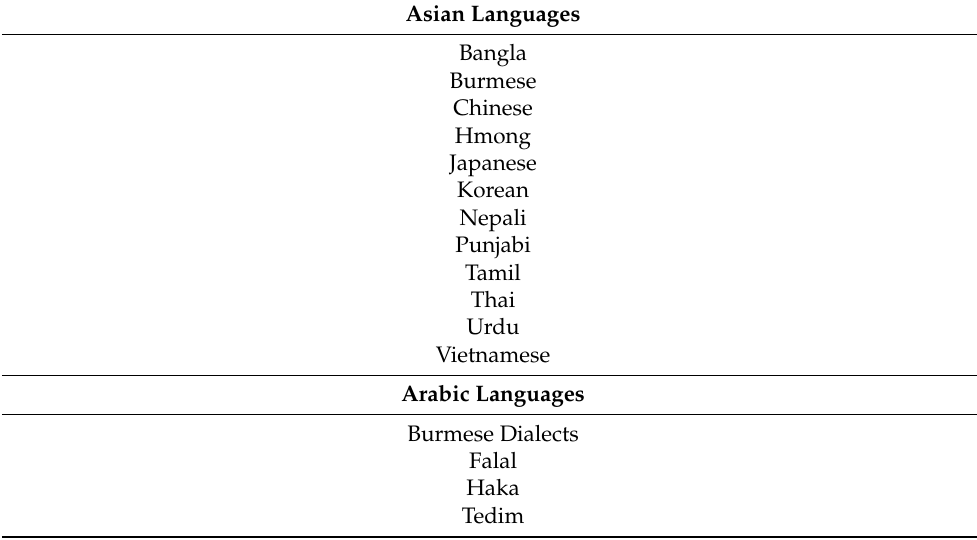
Table 1. Languages of translation for COVID communication